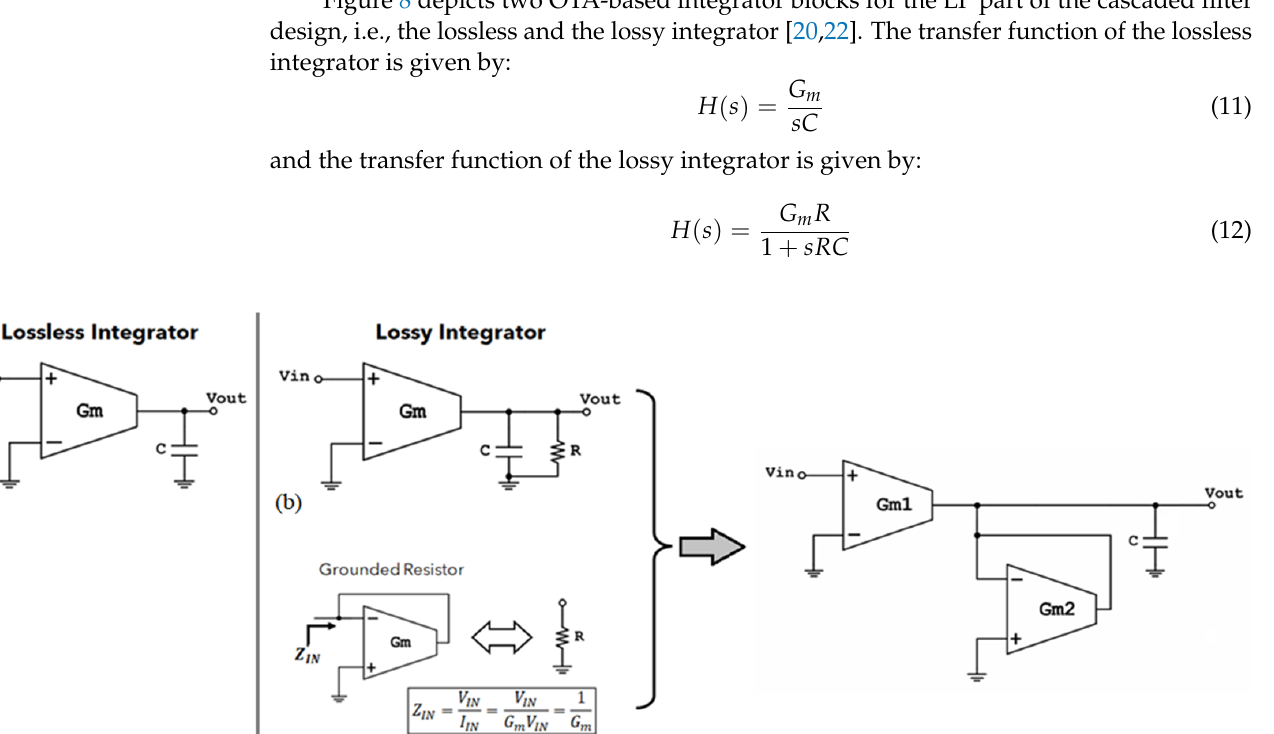
Figure 7. Passive component replacement using OTAs.